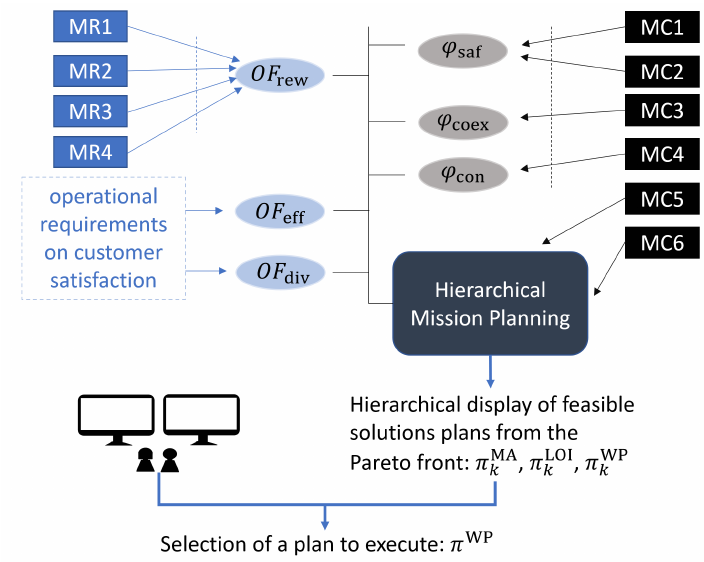
Figure 3. Relationships among the mission requirements (MRs) and mission constraints (MCs) described in Section 2 and the objective functions (OF) and constraints ( ϕ ) presented in Section